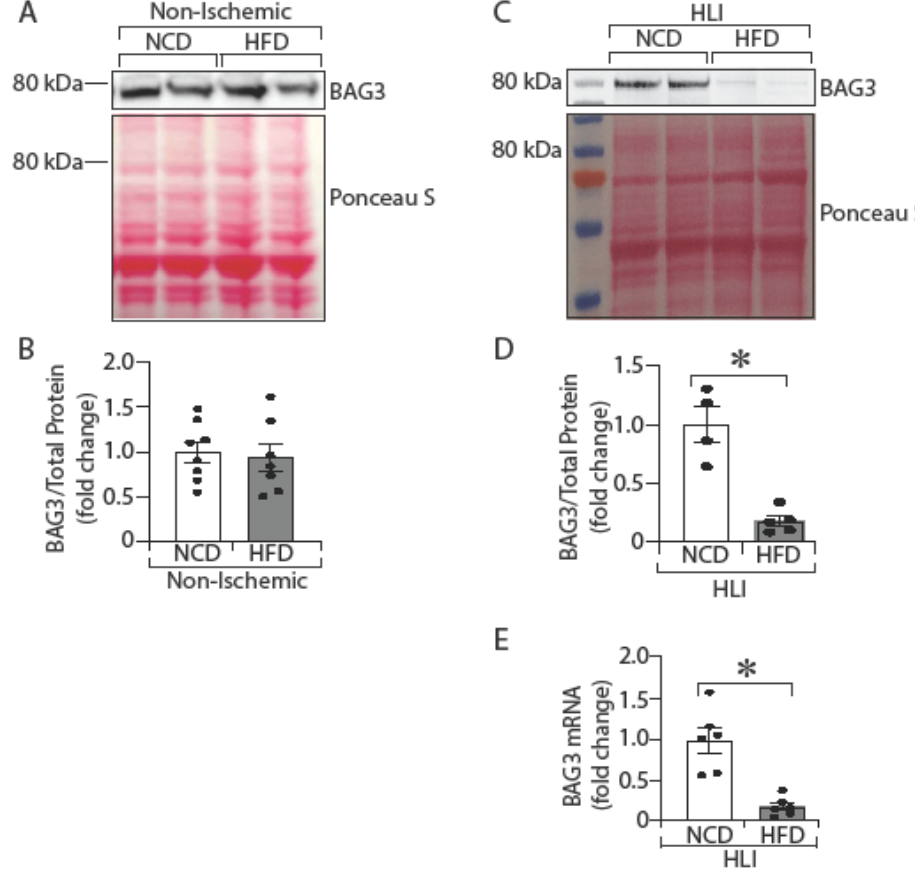
Figure 2. Mice with diabetes have less BAG3 expression in ischemic muscle. C57BL/6J mice were fed with normal chow diet (NCD) or high-fat diet (HFD) for 16 weeks, and hind limb ischemia (HLI) was induced on left limb of mice. After 3 days of HLI, gastrocnemius (GA) muscle samples were collected from both left (Ischemic) and right (Non-Isc; non-ischemic) limbs. BAG3 protein ( A , B ) n = 7–8 was quantified in non-ischemic GA muscles by Western blotting and was normalized with total protein from Ponceau S staining. BAG3 protein ( C , D ) n = 4–5 was quantified in ischemic GA muscle by Western blotting and was normalized with total protein from Ponceau S staining. Additionally, BAG3 mRNA ( E ) n = 6 was determined in ischemic GA muscle by TaqMan qPCR. The results are presented as fold changes vs. NCD. All the values are mean ± SEM. * p < 0.05 vs. NCD.